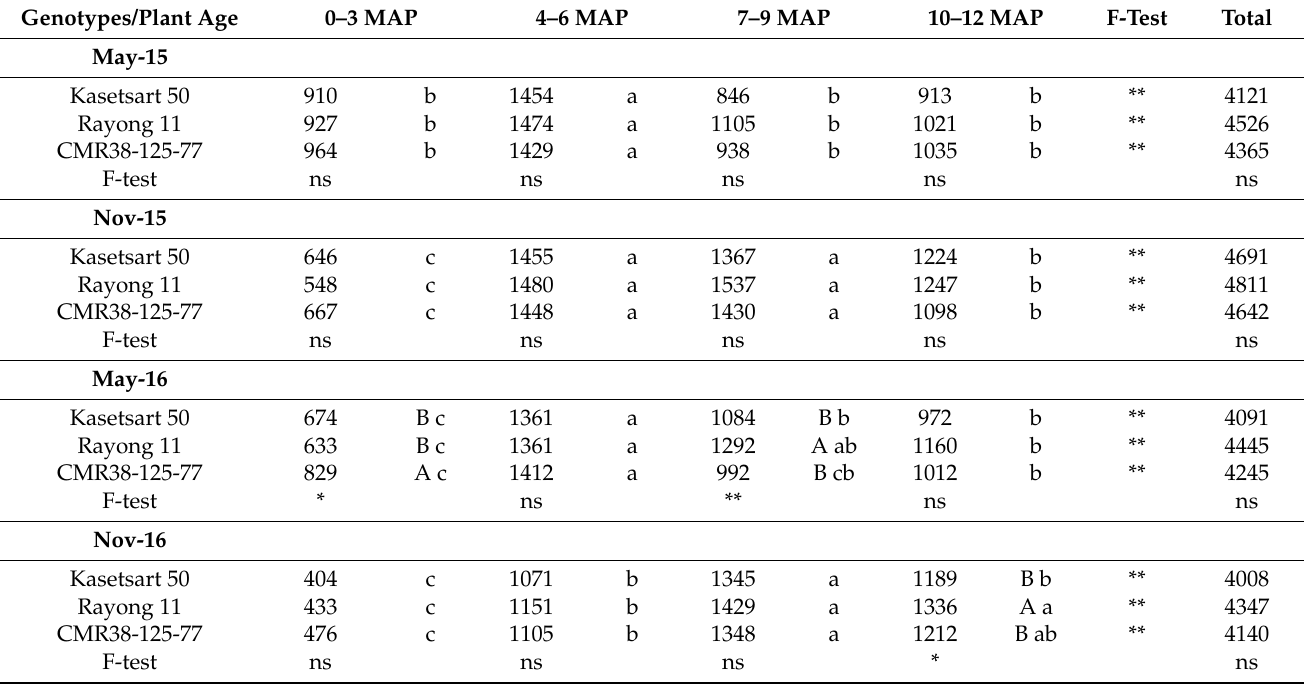
Table 1. Cumulative solar radiation interception (MJ m − 2 ) of 3 cassava genotypes in different growth stages for May and November plants for 2